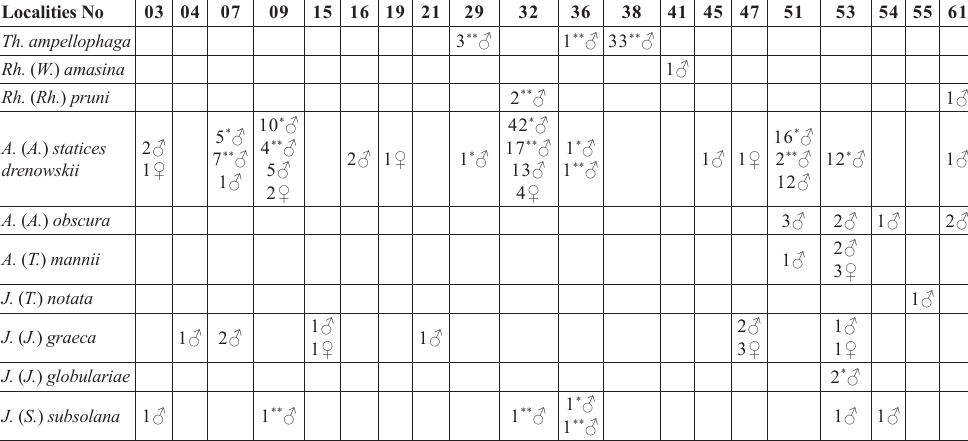
Table 2. Procridinae species caught in the Thrace Region in 2016. Specimens attracted to EFETOV-2 are marked with one asterisk; specimens attracted to EFETOV-S-2 are marked with two asterisks; specimens collected by net are not marked.